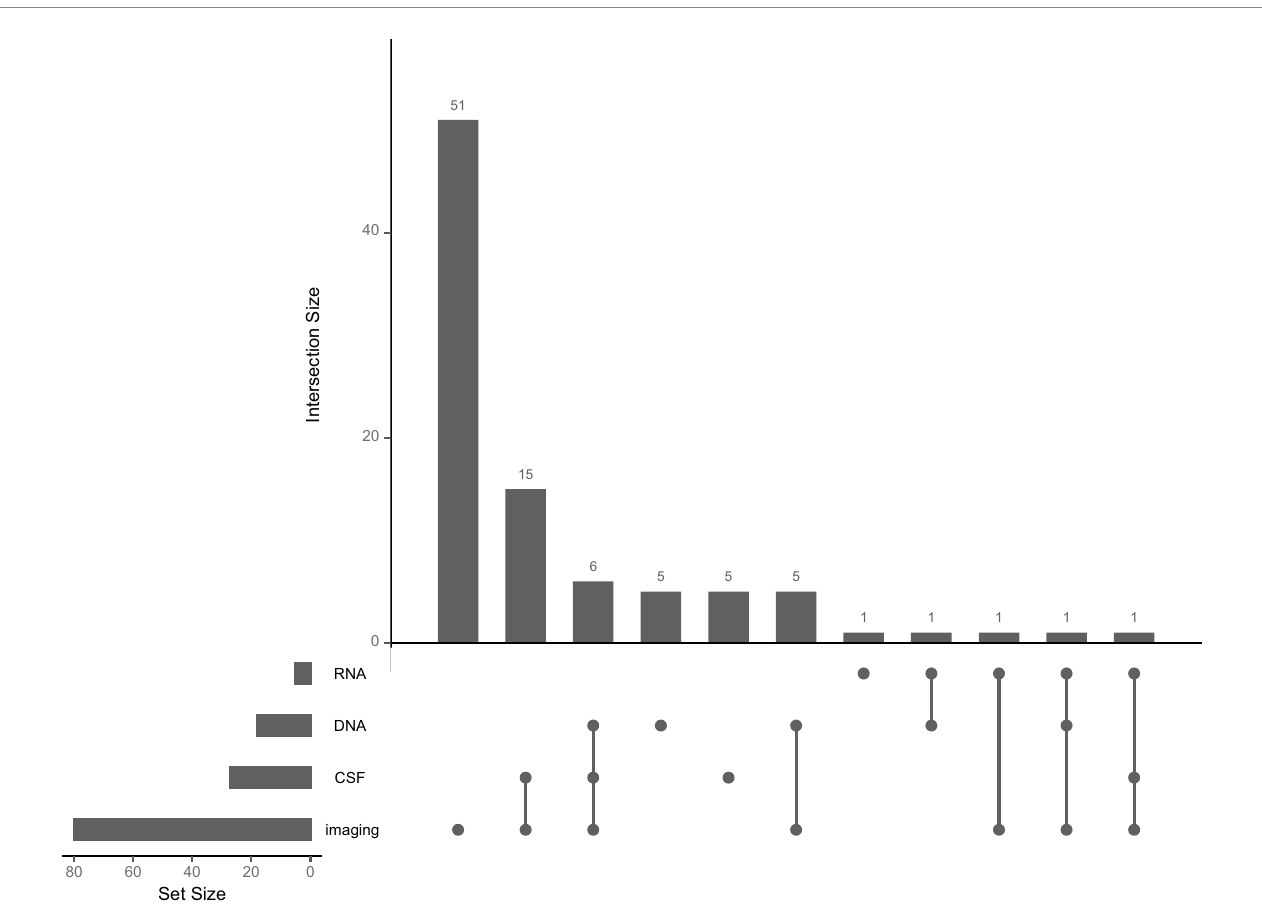
FIGURE 2 The use of multiple biological modalities is rare in machine learning studies of Parkinson’s Progression Markers Initiative data. UpSet plot (Lex et al., 2014; Conway et al., 2017) showing frequencies of different combinations of imaging, CSF, DNA, and RNA data in the machine learning studies we reviewed. Each set of connected dots represents a combination of modalities (bottom). Intersection size is plotted as the number of studies for a particular modality combination (top). The set size is plotted as the overall number of studies using each modality (left). Ninety-two papers used at least one biological modality, including Dopamine Transport imaging striatal binding ratio scores. Thirty studies (out of 110 total) combined multiple biological